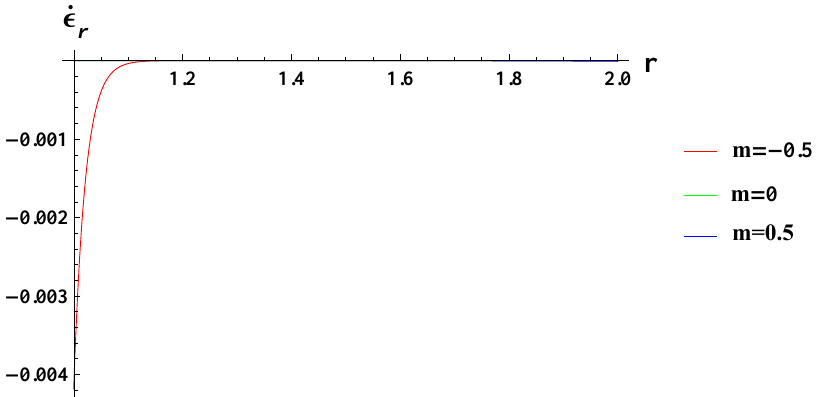
Figure 14. Radial strain rate along the radius r (in cm) of the cylinder, under the effect of rotation ( ω 2 = 50 rad/s), internal pressure p i = 50 MPa and linear volume reinforcement. Tangential strain rate under decreasing reinforcement profile m = − 0.5, as observed from Figure 15 is tensile at internal radial points and becomes compressive at outer radial points of the cylinder. Tangential strain increases with increase in reinforcement of SiC p ( m = 0.5), throughout radii of the cylinder. In cylinder with composite material, tangential strain rate is tensile at inner radius but it becomes compressive towards the outer radius. Figure 16 presents radial stress under the effect of external pressure in a rotating cylinder. Radial stress in a cylinder with increasing reinforcement profile is compressive in nature and its magnitude increases as we move along the radius of the cylinder. Under de- creasing reinforcement profile, radial stress at internal radial points is tensile and decreases towards the outer radial points, becoming compressive in nature. Radial stress under composite material gradation, behaves similar to profile with decreasing reinforcement but has lower order of